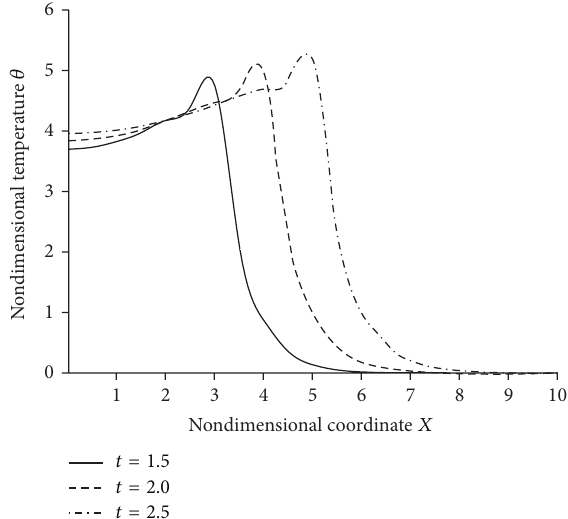
Figure 1: Nondimensional temperature distribution for different 𝑡